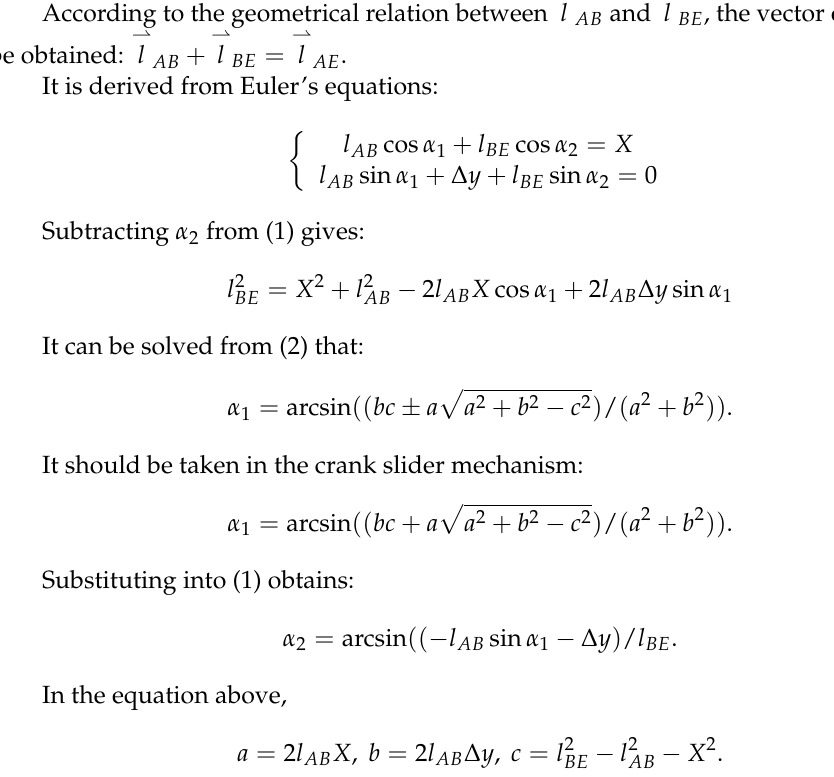
Figure 4. Schematic diagram of the equivalent mechanism of the first configuration.